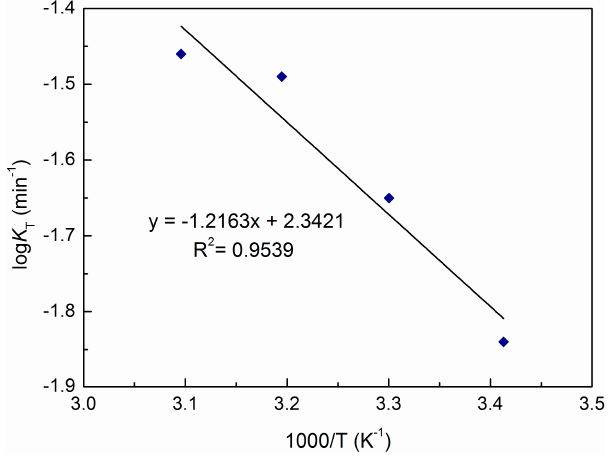
Figure 5. Plot of log k T vs. 1000/ T (Initially, 0.4 g HgO was mixed with 500 mL 0.01 mol/L Na 2 S 2 O 3 solution).